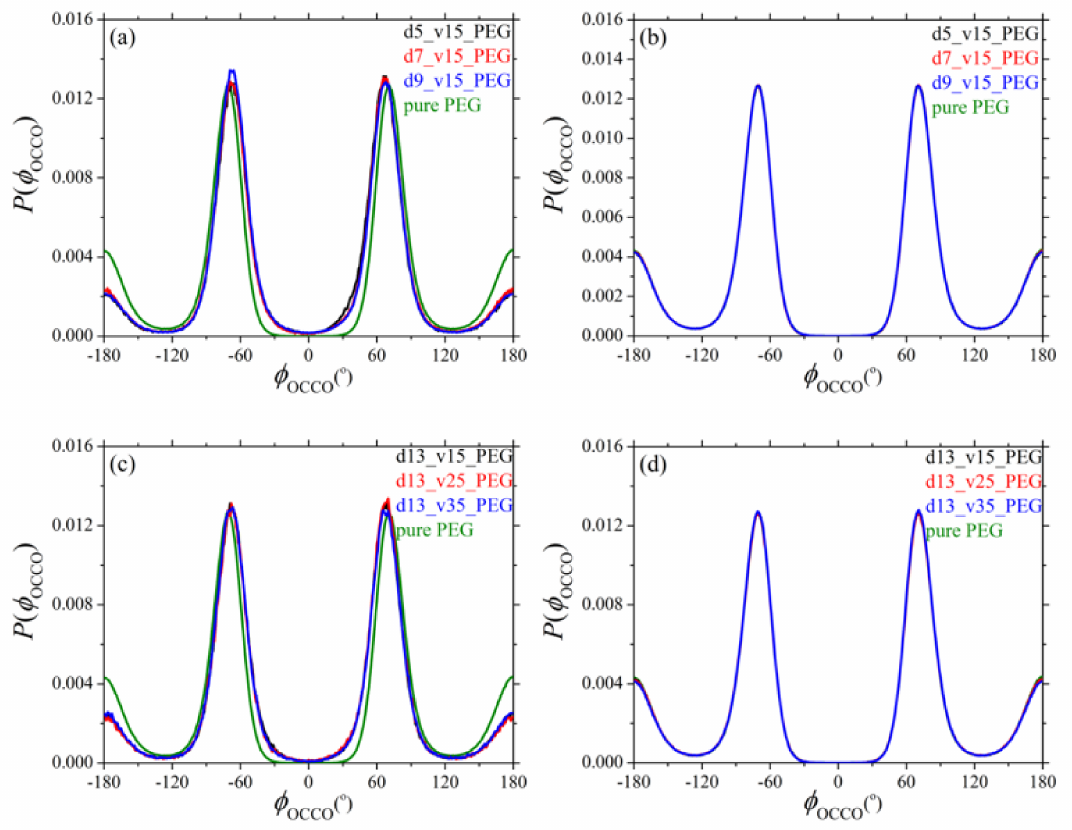
Figure 4. Same as with Figure 3 but for the distribution of the OCCO backbone dihedral. The explanation of ( a – d ) is the same as in Figure